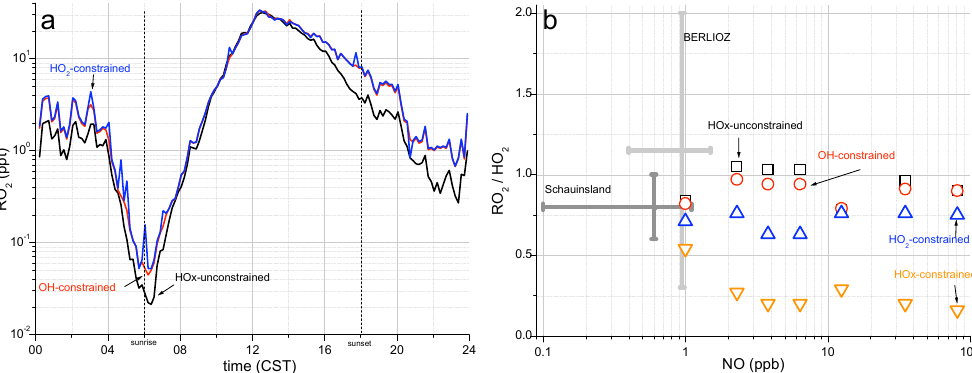
Fig. 5. Predicted RO 2 concentrations (a) and the ratio of RO 2 /HO 2 vs. NO (b) for different modeling scenarios: HO x -unconstrained (black line and squares), OH-constrained (red line and circles), and HO 2 -constrained (blue line and triangles-up), and HO x -constrained (orange triangles-down). The RO 2 concentration demonstrates an expected near-linear dependence on OH concentration. The steady-state models similarly predict RO 2 /HO 2 ratios ∼ 1 at concentrations of NO ranging from 1–100+ ppb; however, the HO x -constrained case predicts a much lower ratio, particularly at high NO ( >